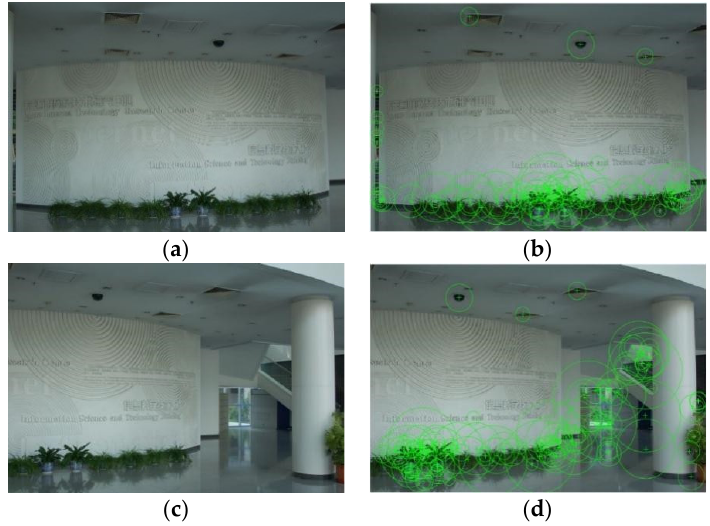
Figure 4. Feature points extraction results of natural images. ( a ) Nature image 1, ( b ) SURF feature points of natural image 1, ( c ) nature image 2, ( d ) and SURF feature points of natural image 2.